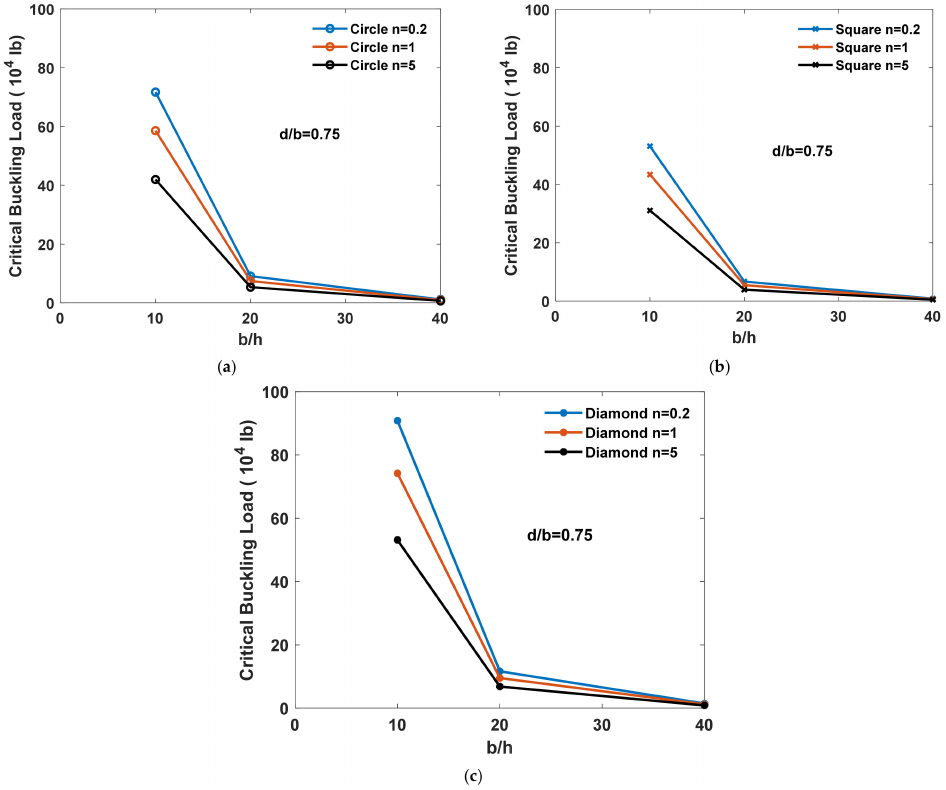
Figure 11. The variation of the aspect ratio on the critical buckling load for ( a ) circle, ( b ) square, and ( c ) diamond opening for an aspect ratio d/b = 0.75.